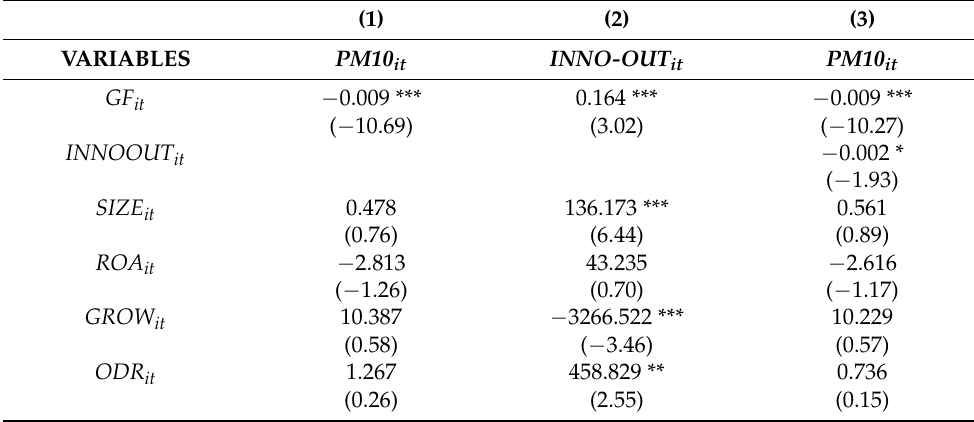
Table 7. Regression results after replacement of dependent